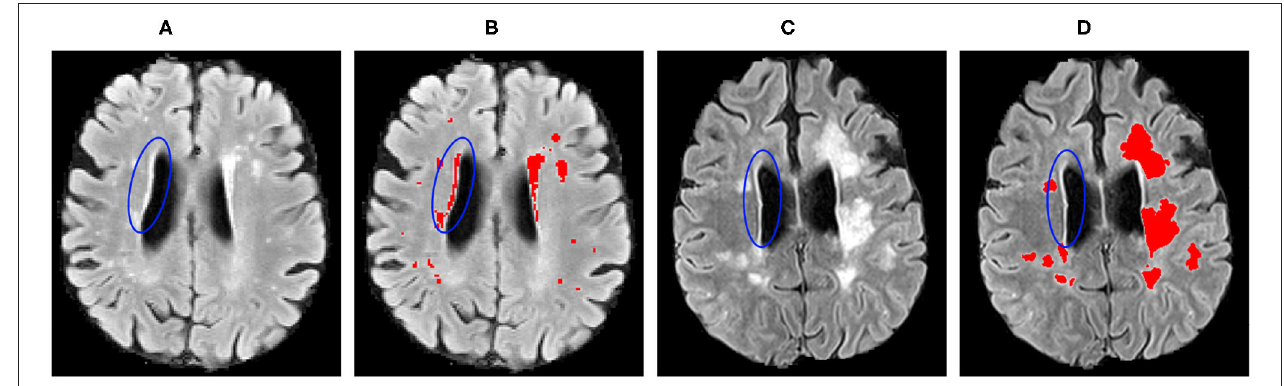
FIGURE 8 | Inter-operator variability in the lesion ground truth masks for the: (A,B) WMH 2017; and (C,D) VH datasets. Blue ellipses indicate the hyperintense tissues near the